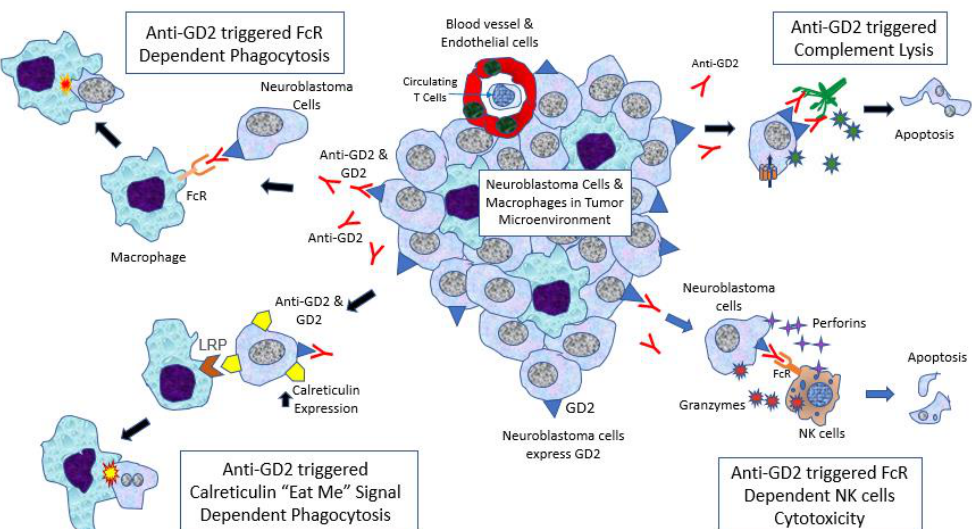
Figure 2. Neuroblastoma tumor microenvironment and cytotoxic action induced by anti-GD2. (1)